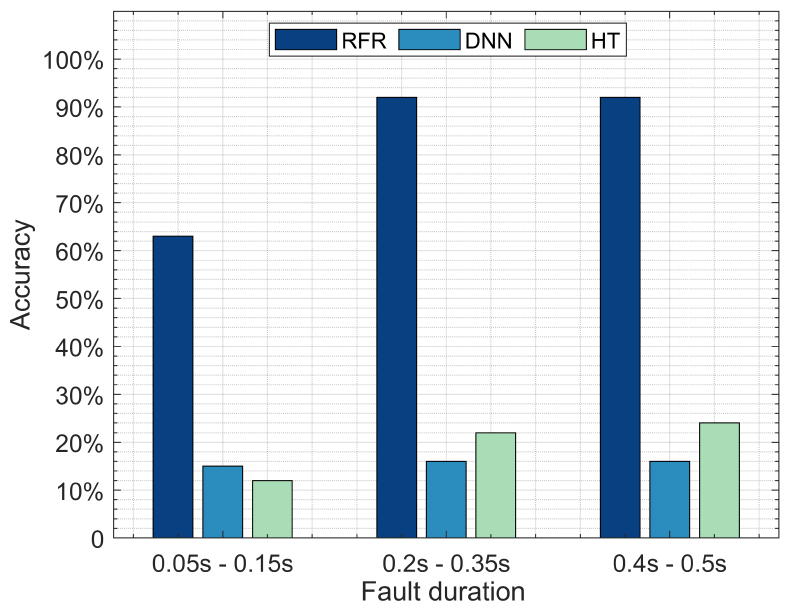
Figure 6. Accuracy of RF, DNN, and HT in terms of detecting fault location with various duration.